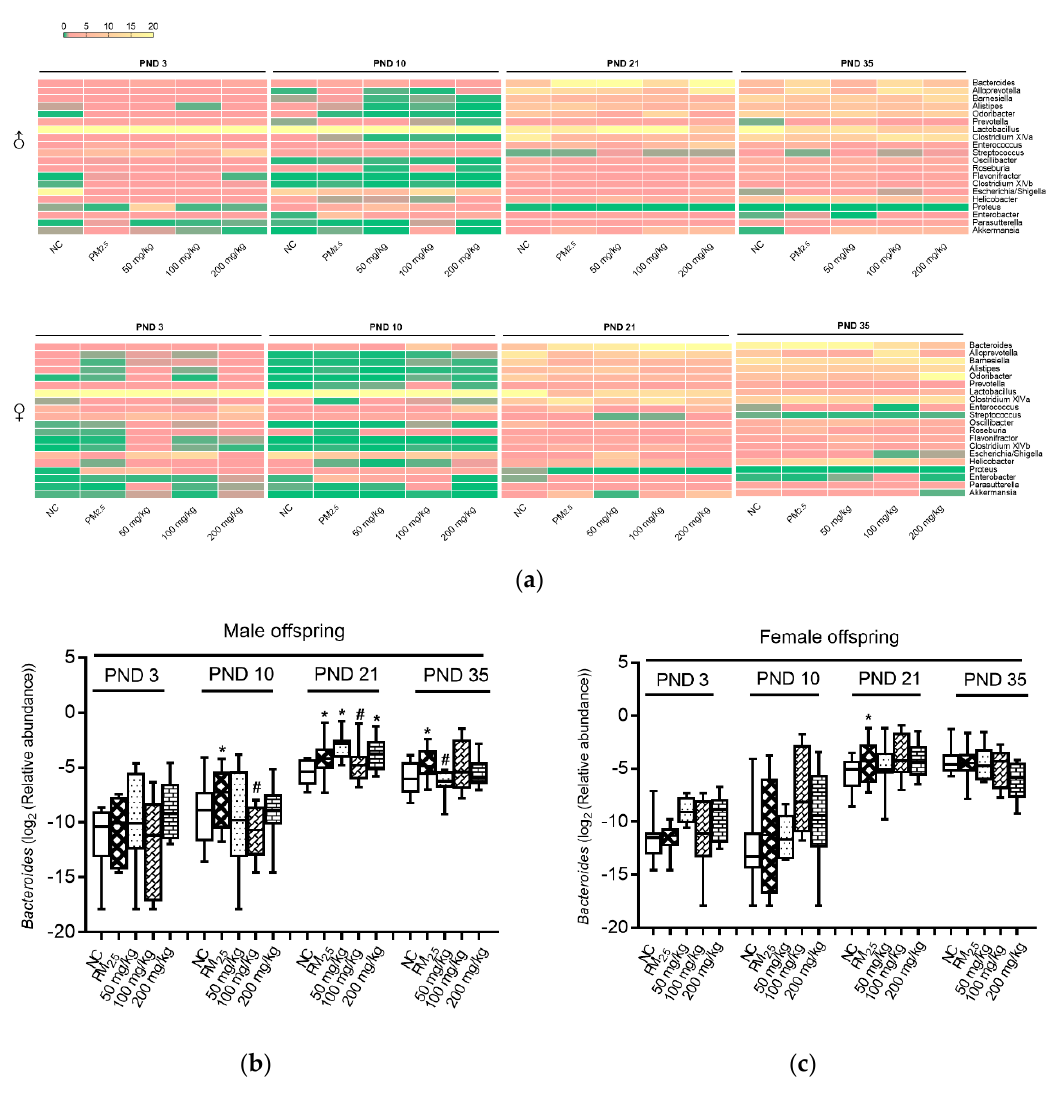
Figure 5. Axonomic composition of gut microbiota. ( a ) Axonomic composition of the top 20 genera; ( b ) Bacteroides of male offspring mice; ( c ) Bacteroides of female offspring mice. Compared with the NC group, * indicates p < 0.05. Compared with the PM 2.5 group, # indicates p < 0.05.